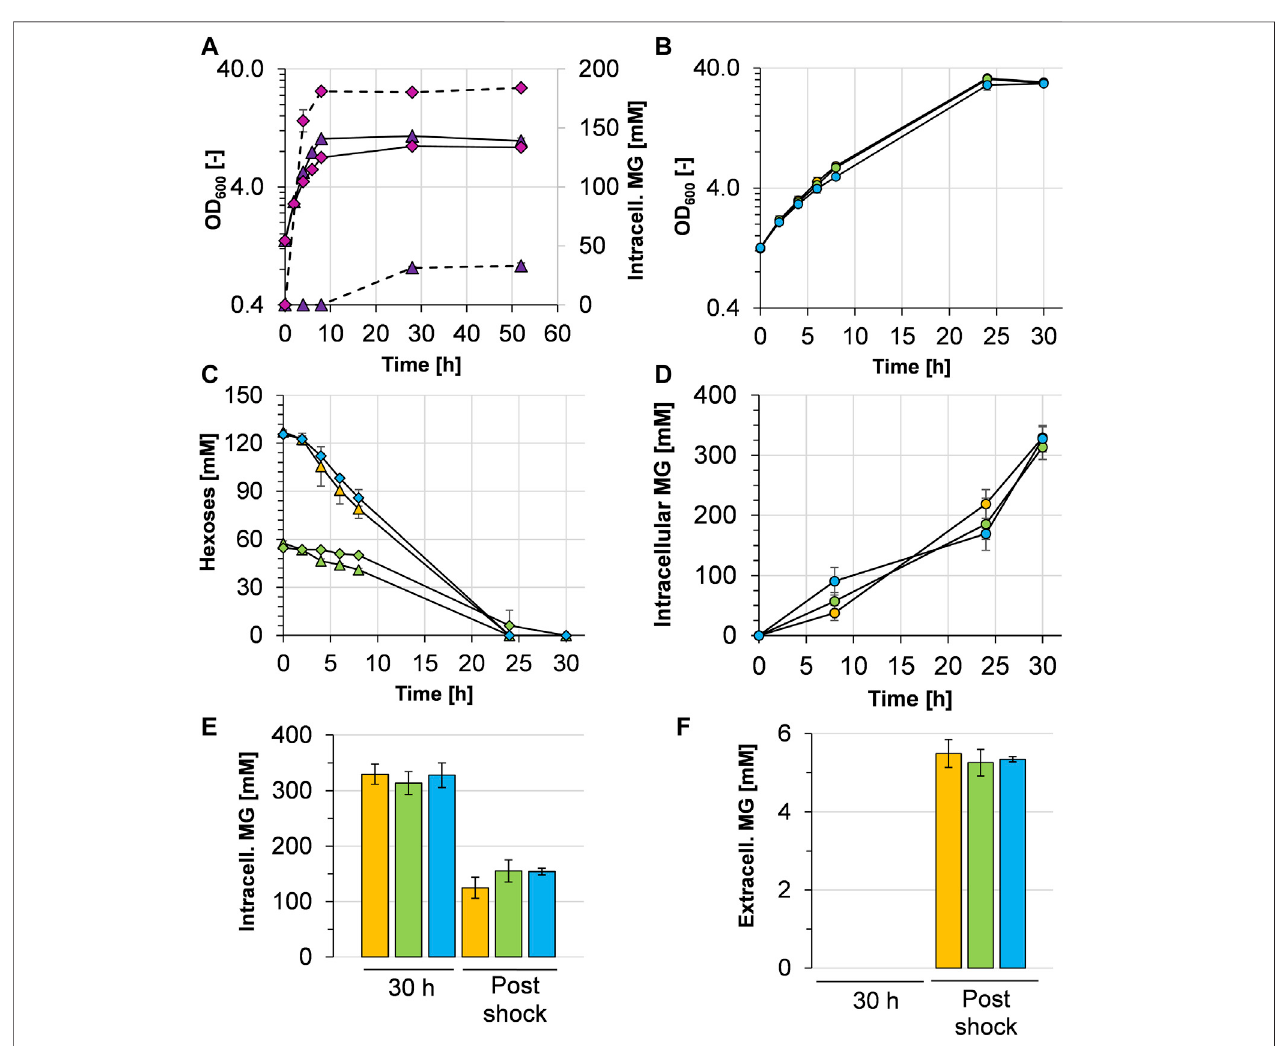
FIGURE 3 | Growth characteristics and mannosylglycerate (MG) production behavior of C. glutamicum (pEKEx3 mgsD ) (pVWEx1 manA ) grown in different media. (A) Growth (solid lines) and intracellular MG concentration (dashed lines) in 2xYT complex medium with IPTG-induction (pink diamonds) and without IPTG-induction (purple triangles). (B) Growth and (C) hexose (glucose and mannose) consumption of C. glutamicum (pEKEx3 mgsD ) (pVWEx1 manA ) in CGXII minimal medium containingeither2%glucose(orangesymbols),1%glucoseplus1%mannose(greensymbols),or2%mannose(bluesymbols)withthecorrespondingintracellular (D) and extracellular (E) MG concentrations, the latter upon cold shock with ultrapure H 2 O. Before the cold shock, extracellular MG concentrations were below the detection limit. Growth in (B) is represented by closed circles; glucose and mannose concentrations in (C) are represented by triangles and diamonds, respectively. Experiments were conducted in biological triplicates and the standard deviation is given as error